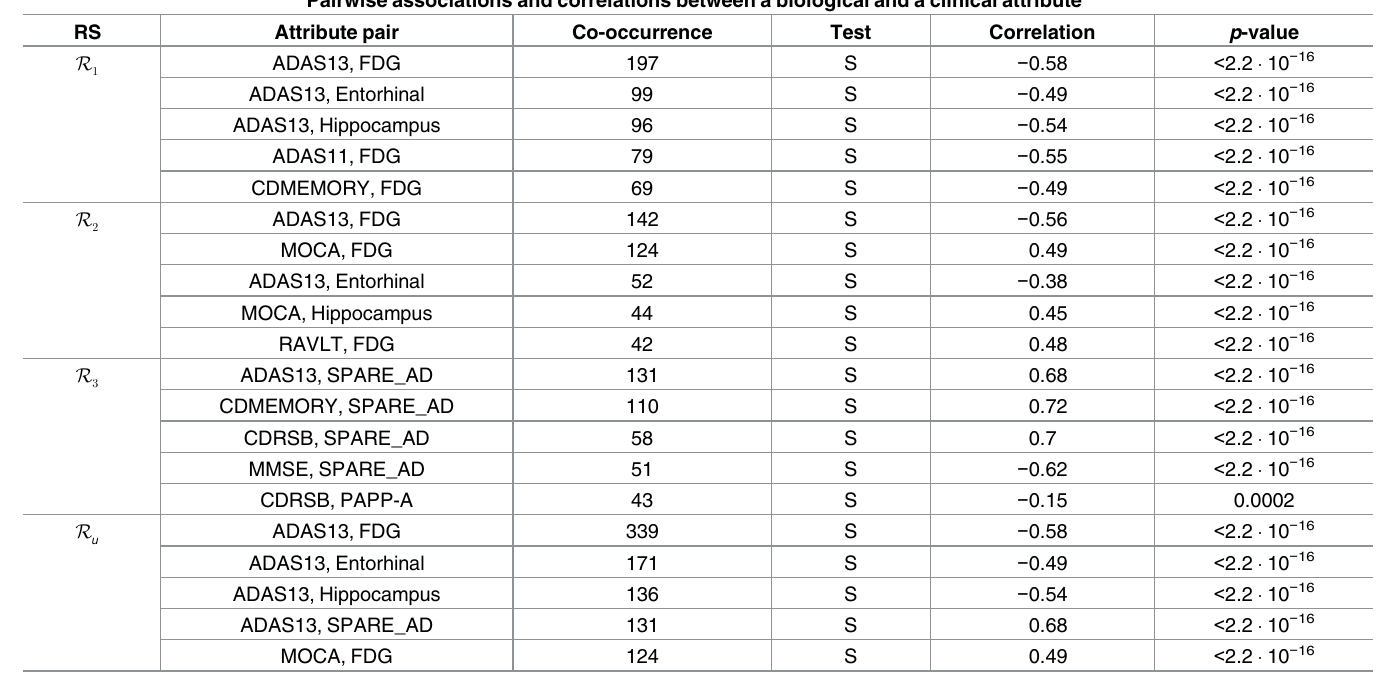
Table 9. The top five associations between pairs of attributes consisting of a clinical and a biological attribute. The associationis measuredas their co-occurrence in redescription queries. Attribute correlations for a redescriptionset R are computedon dataset D i . P denotesthe Pearson correlation coeffi- i ¼ R [ R [ R cient and S denotesthe Spearman’s correlationcoefficient. R . Correlationsfor attribute pairs from the redescriptionset R 1 2 3 u the largest dataset containing both attributes. Pairwise associations and correlations between a biological and a clinical